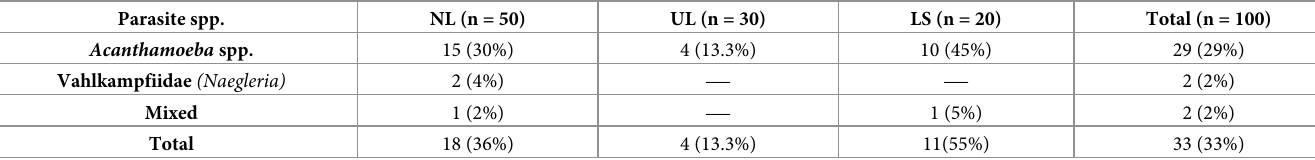
Table 1. Presence of Acanthamoeba , free living amoeba, and mixed genera in the examined samples. Parasite spp.